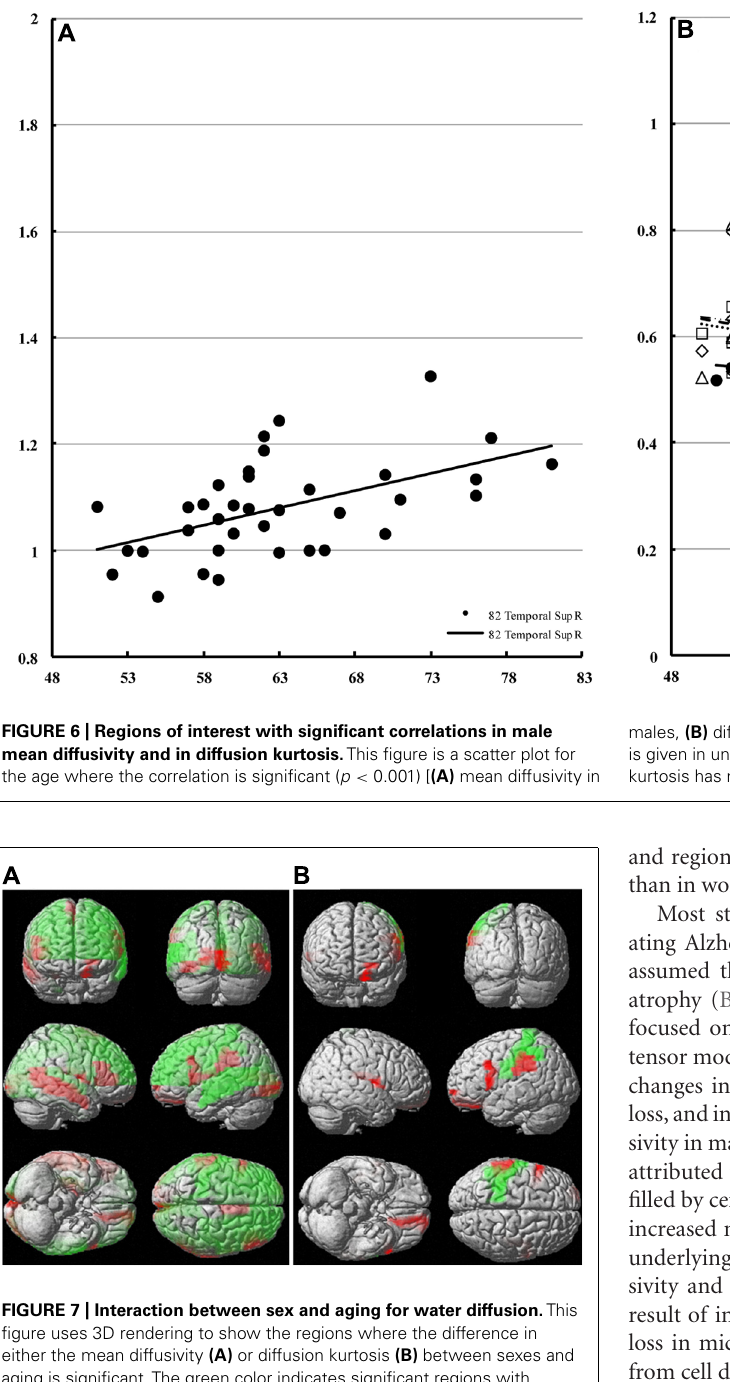
FIGURE 7 | Interaction between sex and aging for water diffusion. This figure uses 3D rendering to show the regions where the difference in either the mean diffusivity (A) or diffusion kurtosis (B) between sexes and aging is significant.The green color indicates significant regions with respect to aging, and the red color shows significance between